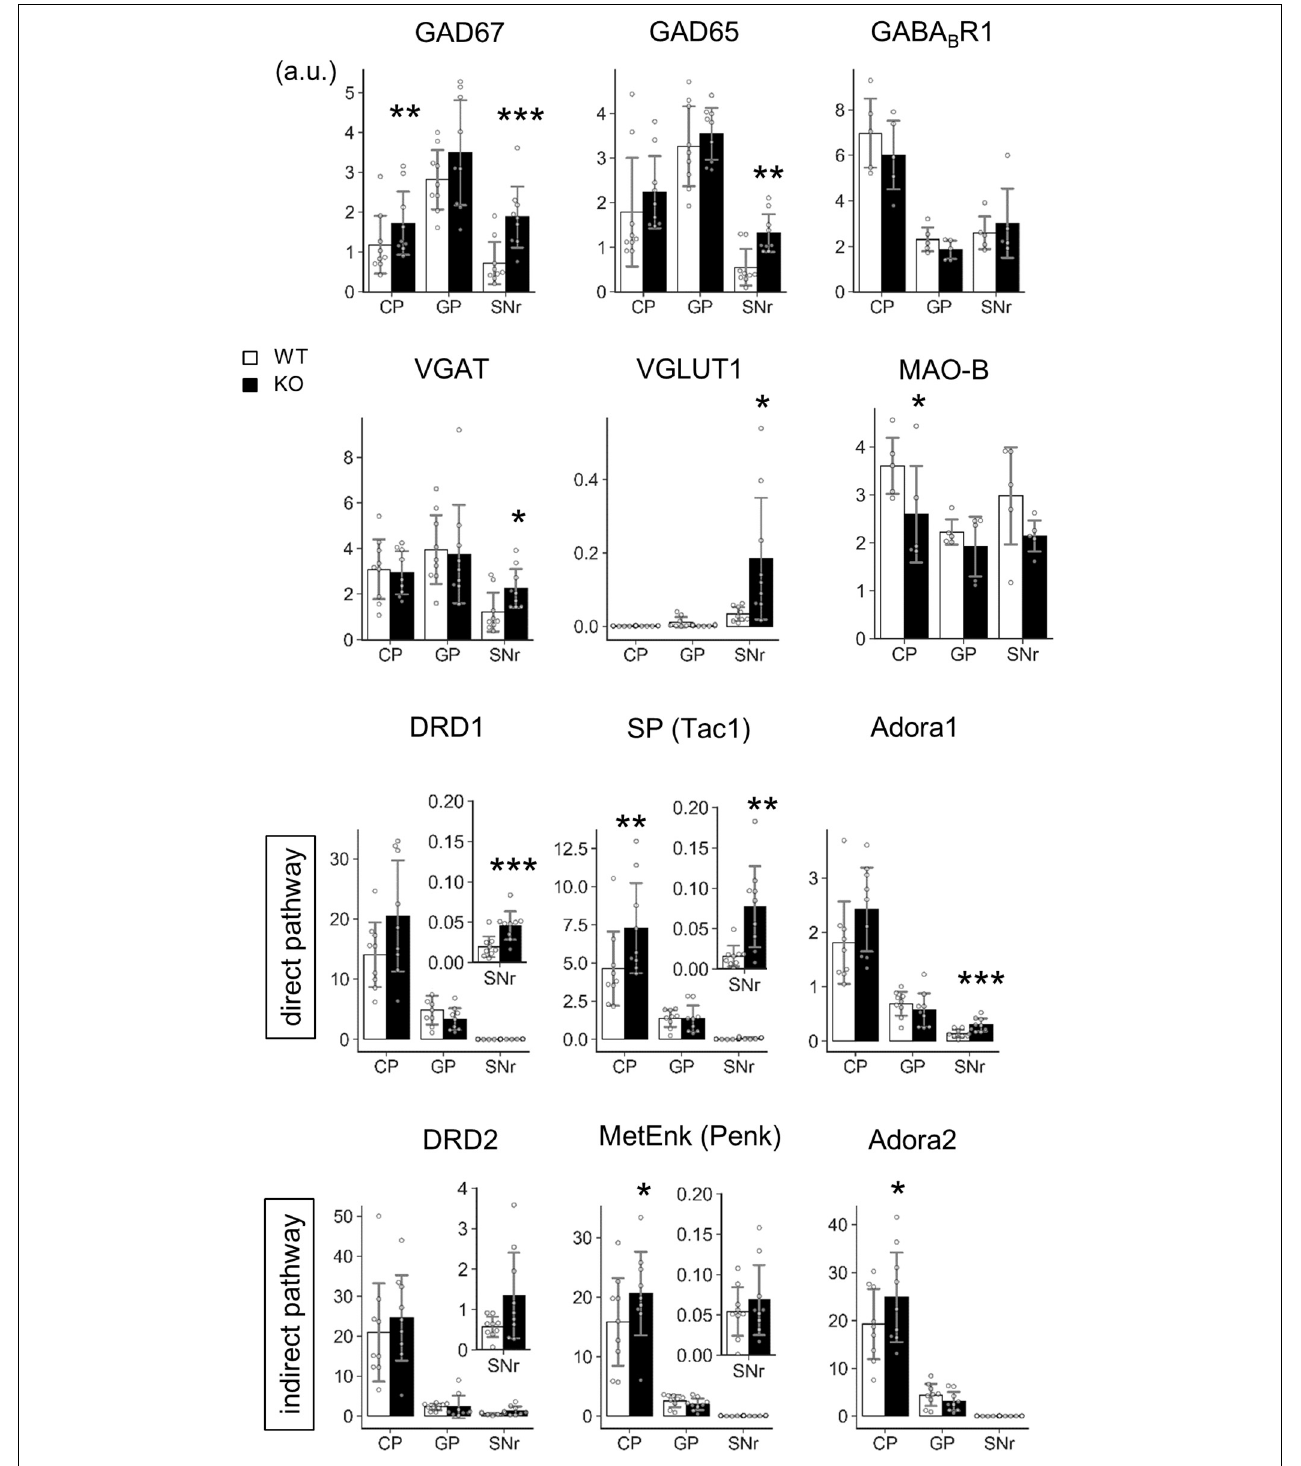
FIGURE 8 | Transcript level analysis of Lrtm2 KO striatal projections. Transcript levels of the indicated proteins are determined by quantitative PCR analysis using frozen brain punches from the caudoputamen (CP), globus pallidus (GP), and SNr. 6–14 M-old mice ( n = 9, 4 males and 5 females for each genotype) were analyzed. The mean of three GAPDH normalized RNA level values is used as a representative mRNA level value for a mouse. Gray circles indicate the individual values for each mouse. * p < 0.05; ** p < 0.01; *** p < 0.001 in paired t -test. Error bars , SD. Scale, arbitrary unit. Relative transcript levels (WT = 100%) are indicated in Supplementary Figure 6